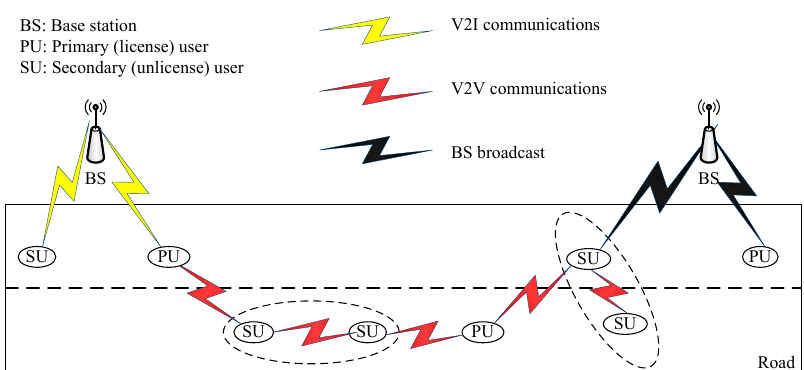
Figure 4. The concept of the cooperation-assisted spectrum handover (CASH).